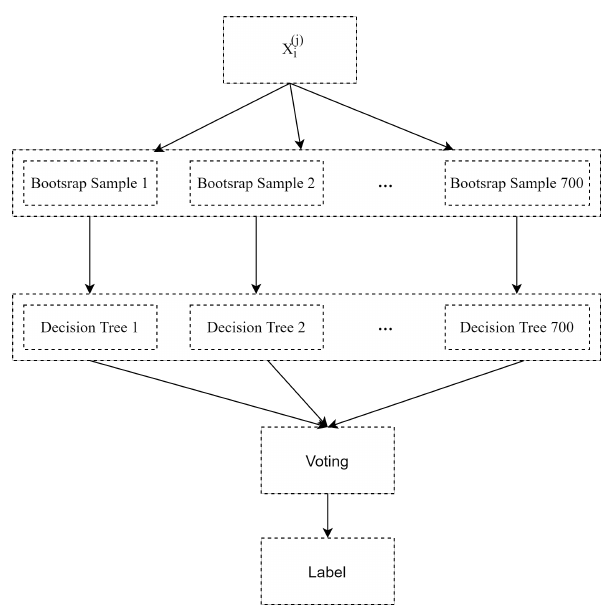
Figure 2. The flow chart of the random forest